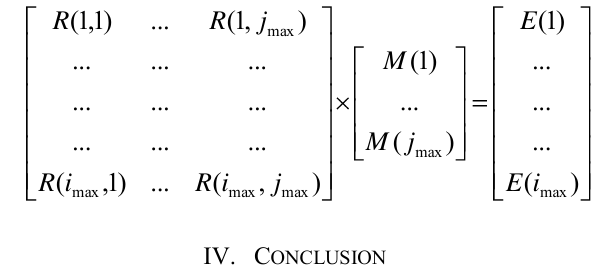
Fig. 2 Example of experimental number of counts per 16-μs channel as function of measurement time. Fig. 3 The dependence of FOM on the shift of the FM detector.